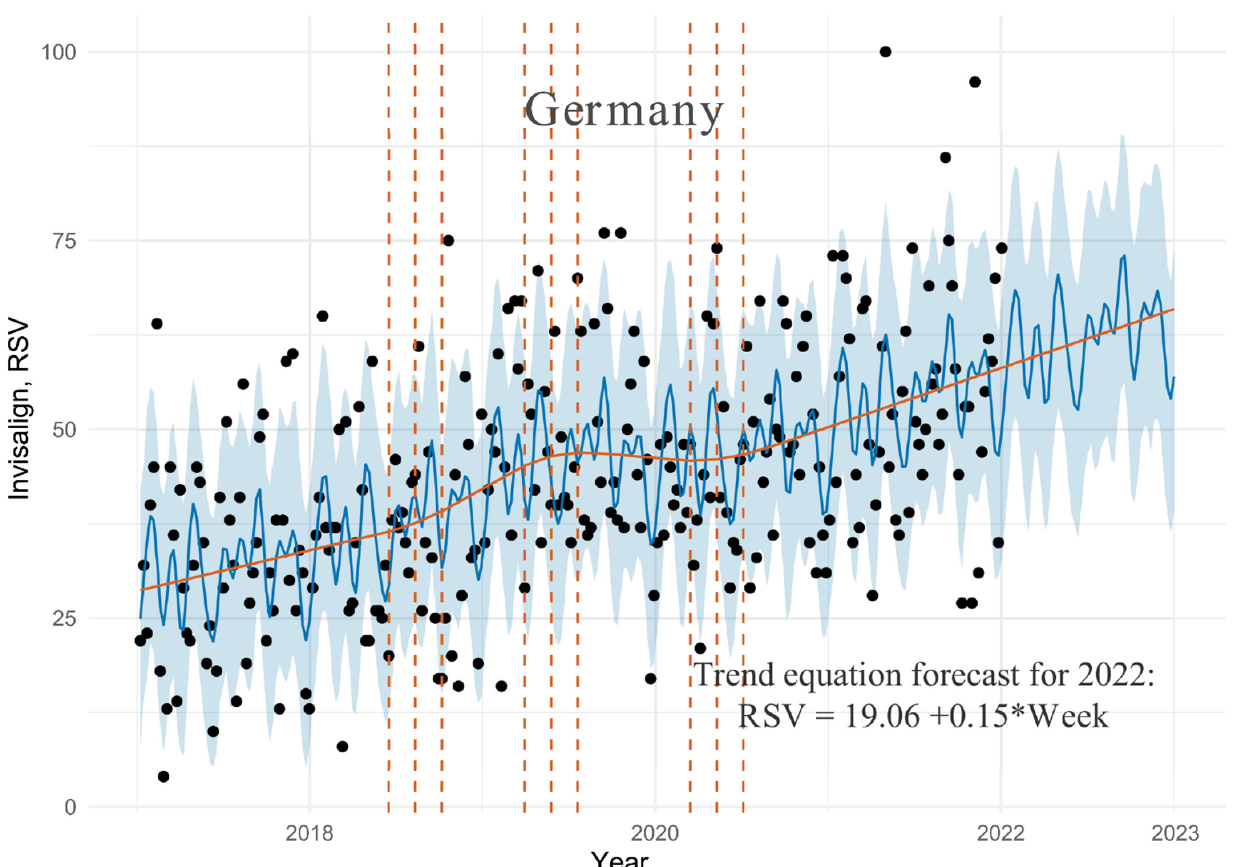
Figure 1. Graph of GT time series distribution for search results for keyword “Invisalign” in Germany with the fit and prediction by Prophet algorithm and trend equation forecast for 2022, where “Week” is the week number counted from the beginning of dataset (8 January 2017).